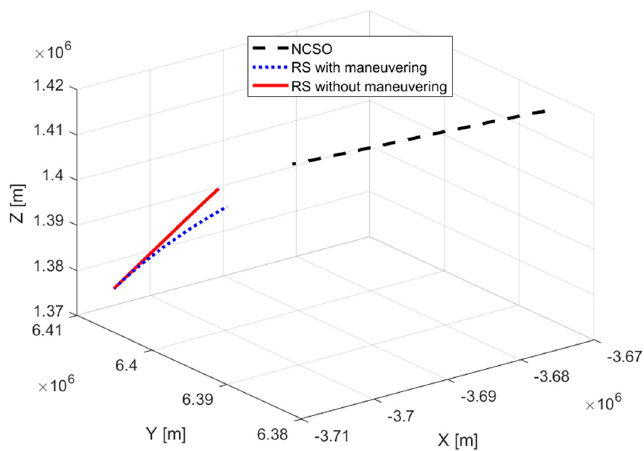
Figure 4. Simulated orbits of NCSO and RS.